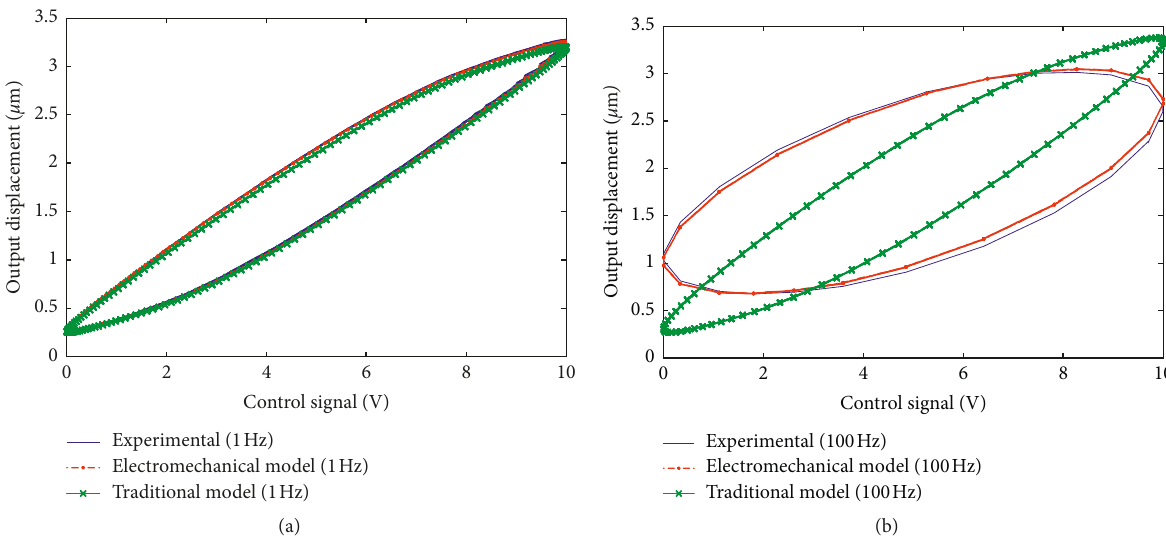
Figure 6: Comparisons of hysteresis characteristics between the experimental and the modeling results under sinusoidal control signals with different frequencies. (a) 1 Hz. (b) 100Hz.